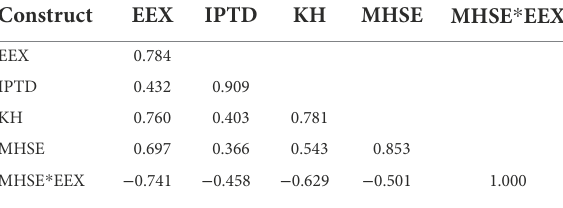
TABLE 7 Discriminant validity (Fornell-Larker-1981 criteria; moderation). Construct